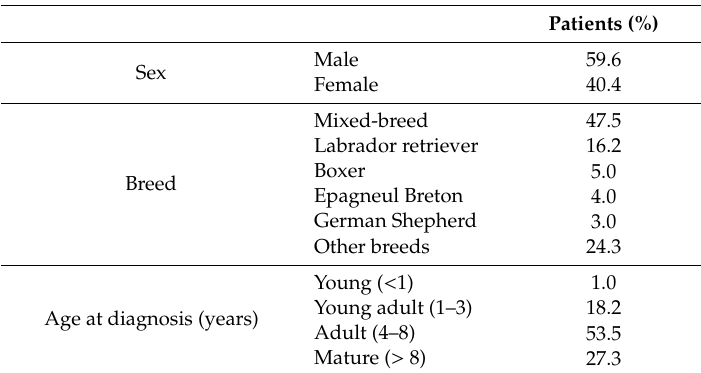
Table 1. Patient signalment, n =